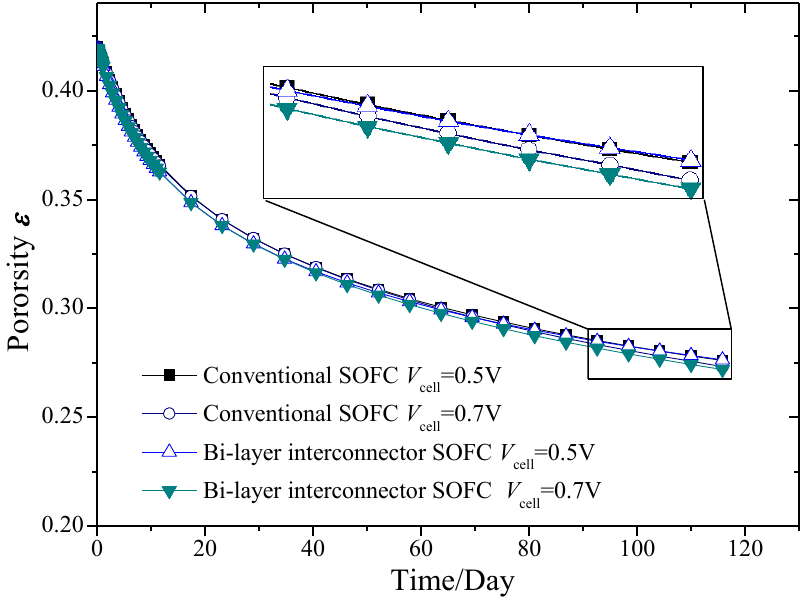
Figure 7. Variation of porosity for SOFC models with different